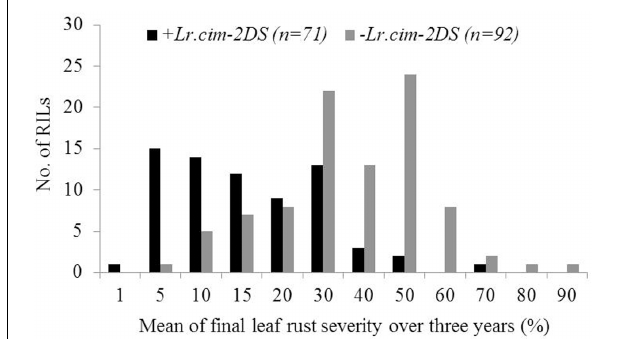
FIGURE 6 | Comparison of UC1110/PI610750 recombinant inbred lines (RILs) for mean final leaf rust severity in the presence (+) and absence (–) of the leaf rust resistance QTL Lr.cim-2DS over 3 years of field trials. The numbers of RILs in each category are shown in